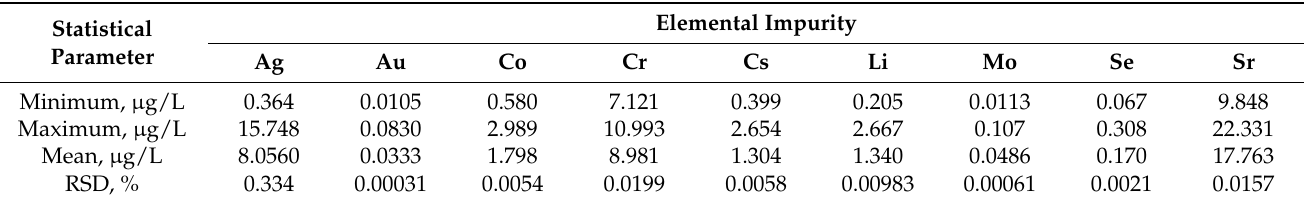
Table 4. The descriptive statistics of examined elements in each analysed sample (GT1–GT12).